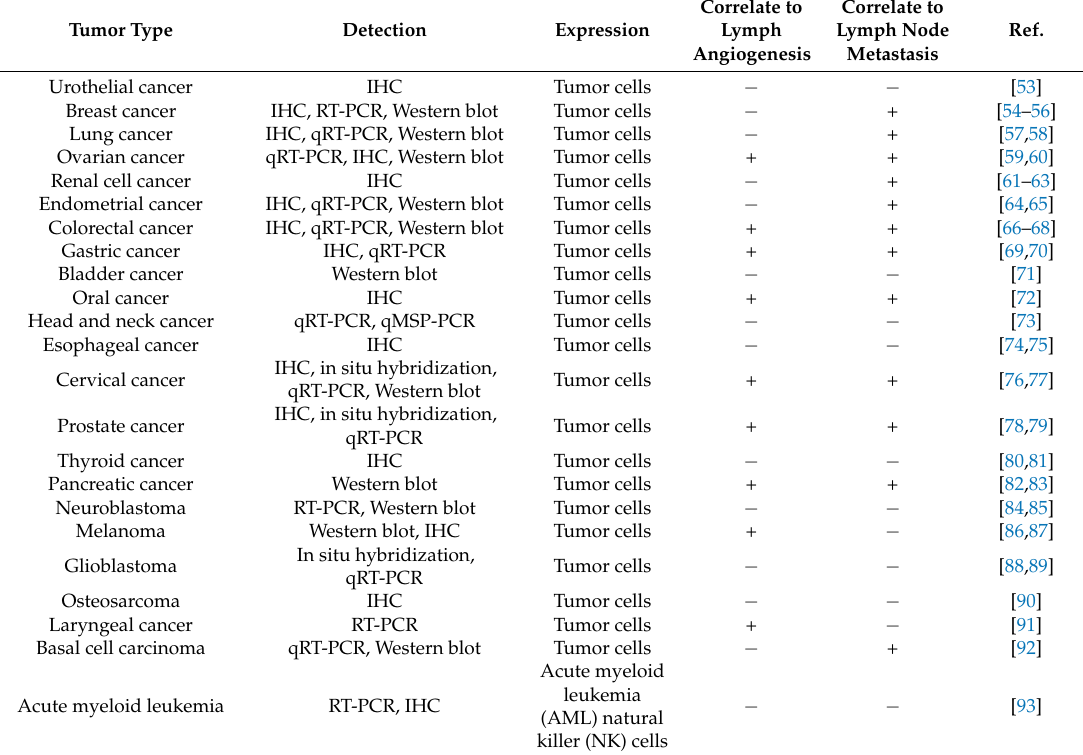
Table 1. Expression of VEGFR3 in tumor